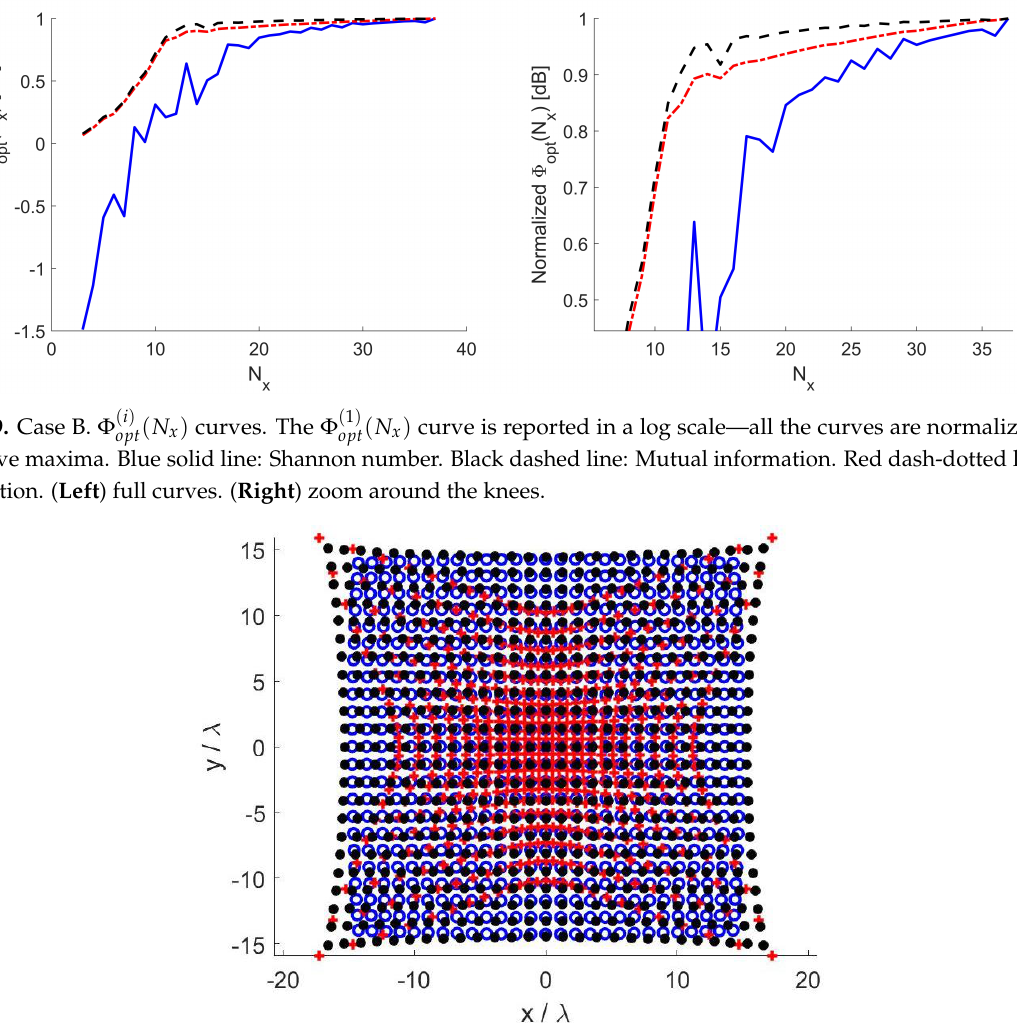
Figure 10. Case B—Optimized sampling points. Blue circles: Shannon number. Black dots: Mutual information. Red pluses: Fisher information.